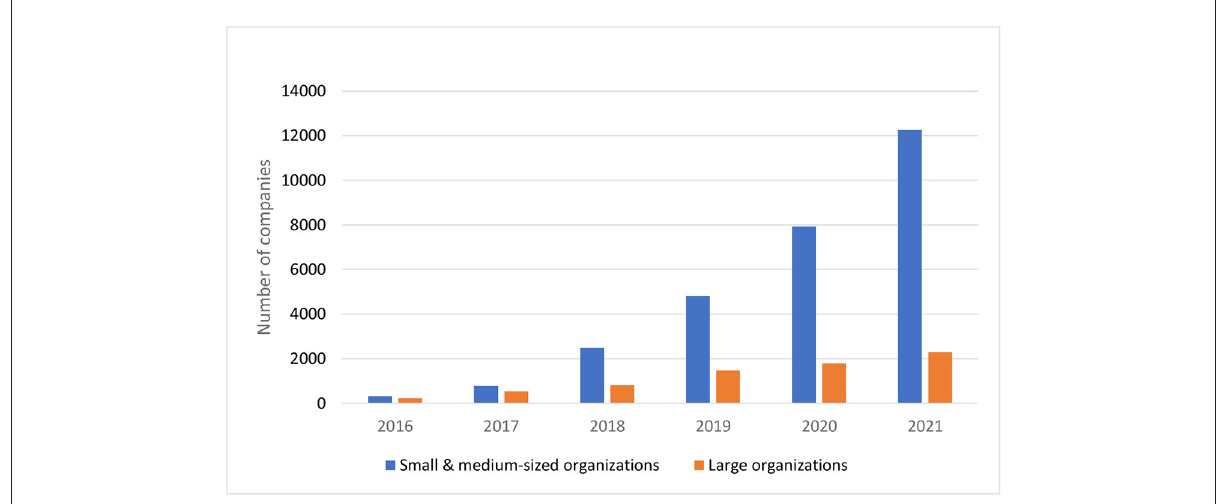
FIGURE1 Certified H&PM outstanding organizations.